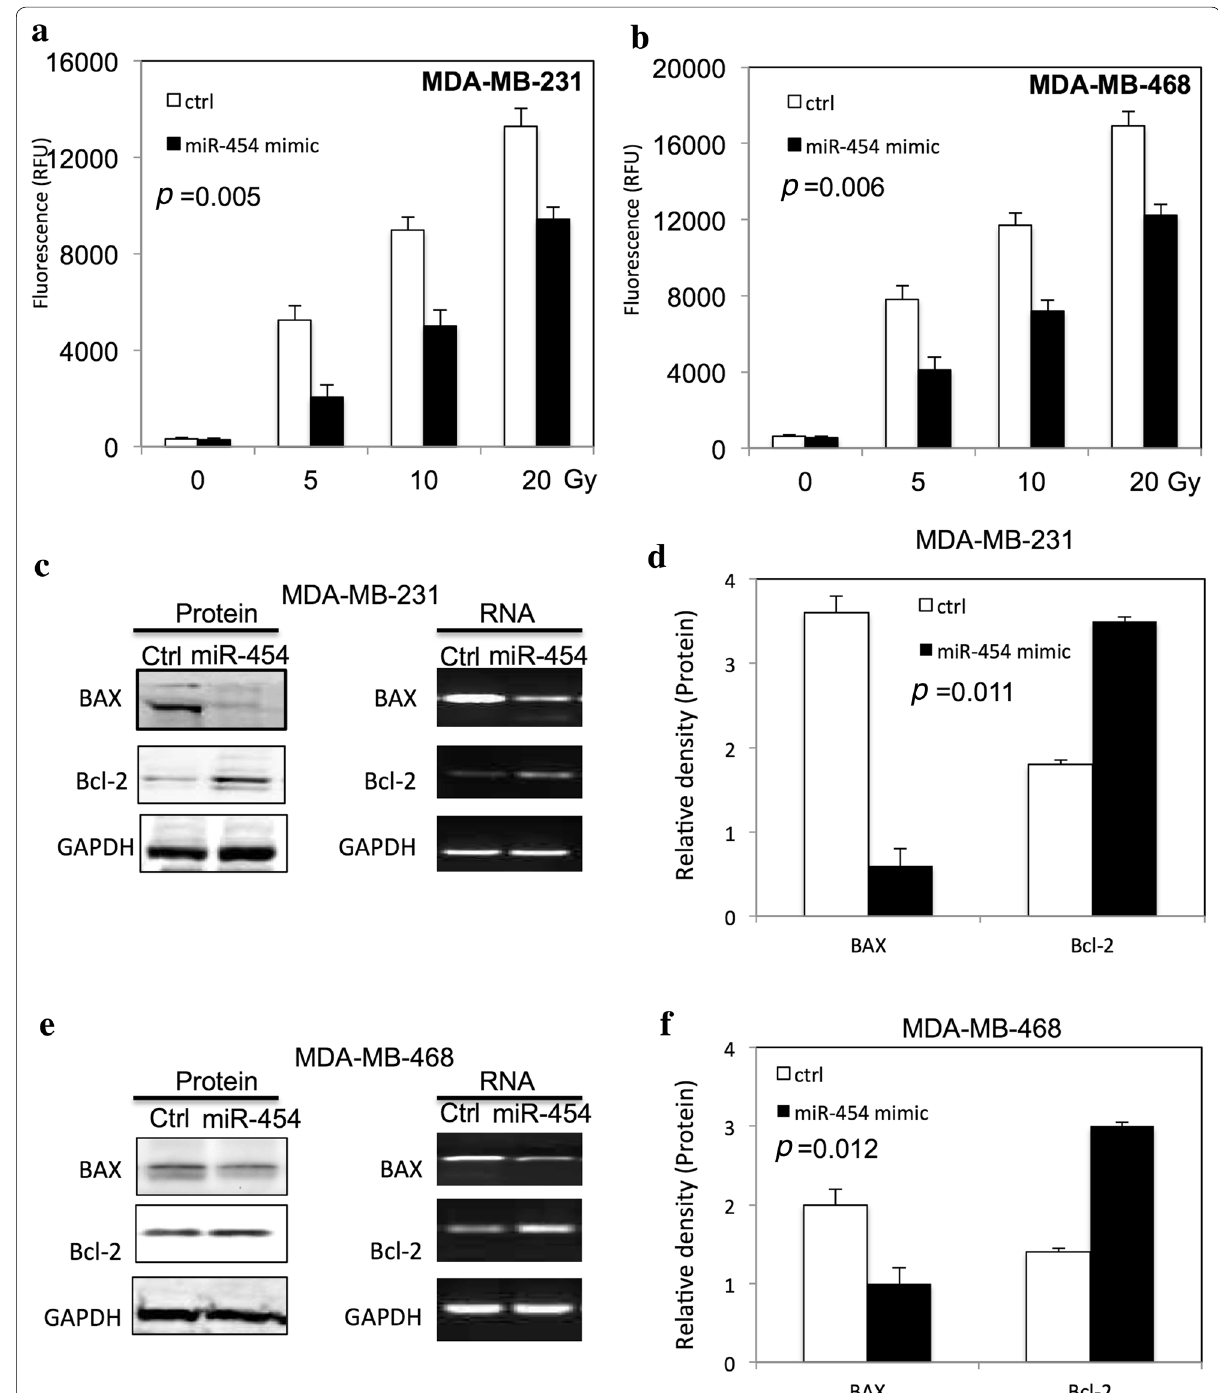
Fig. 3 miR-454 inhibits radiation-induced apoptosis in TNBC cells. a The caspase 3/7 activity of MDA-MB-231 cells transfected with miR-454 mimic after different doses of ionizing radiation. b The caspase 3/7 activity in MDA-MB-468 cells transfected with miR-454 mimic after different doses of ionizing radiation. c , d The apoptotic proteins and RNA levels in MDA-MB-231 cells after transfection of miR-454 mimic. e , f The apoptotic proteins and RNA levels in MDA-MB-468 cells after transfection of miR-454 mimic. All experiments were performed in